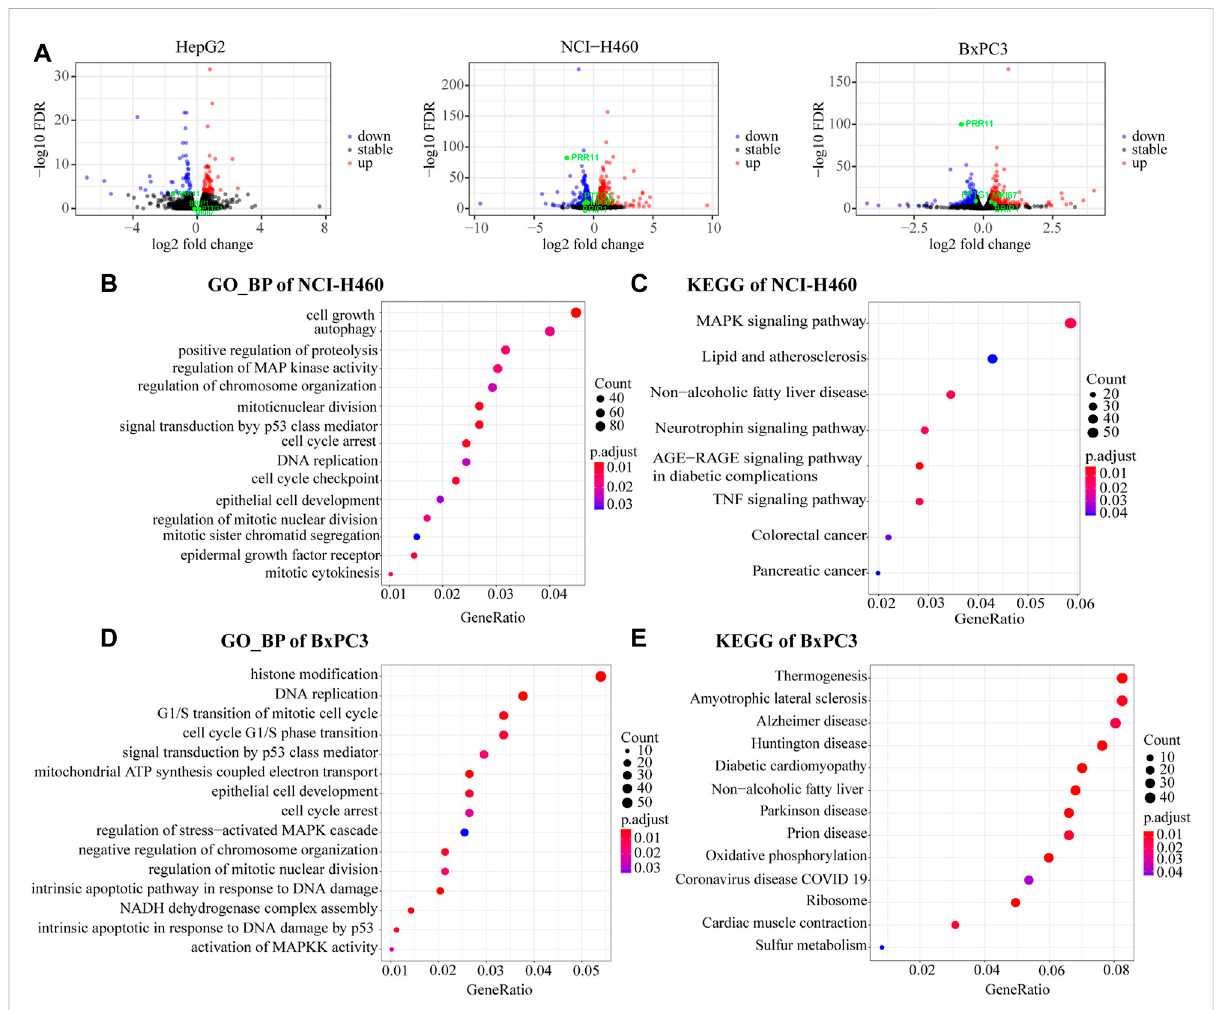
FIGURE 3 Functional enrichment analysis of RNA-Seq DEGs. (A) Volcano maps of HepG2 (left panel), NCI-H460 (middle panel), and BxPC3 (right panel). DEGs with threshold of |FC| > 1.2 and FDR < 0.1. PRR11 , PTTG1 , and MKI67 were marked in green. (B,C) GO_BP and KEGG pathways of NCI-H460 DEGs. (D,E) GO_BP and KEGG pathway of BxPC3